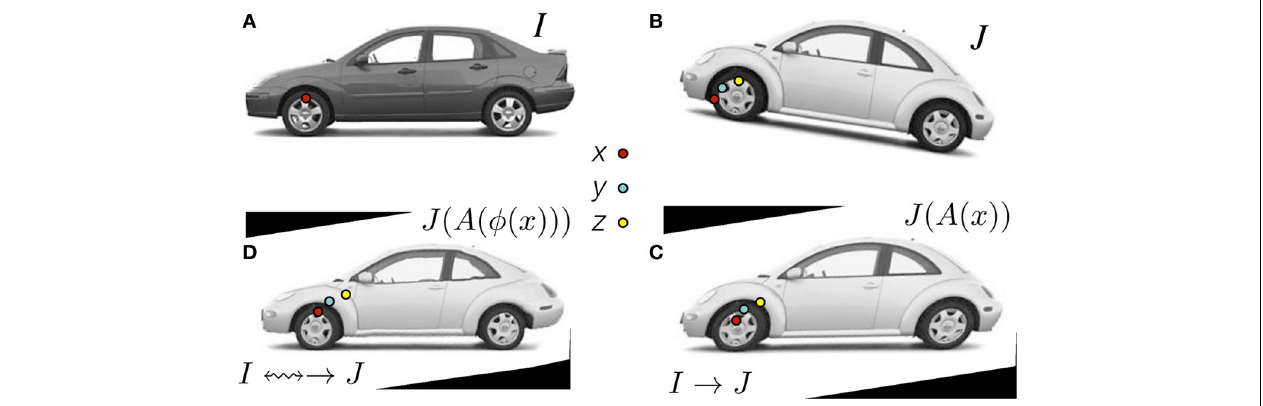
FIGURE 2 | Clockwise: Define x in (cid:2) I and z in (cid:2) J as the same material point but existing in different domains. The point y is in a domain that is intermediate between (cid:2) I and (cid:2) J . The standard approach in the ITKv4 registration framework is to map image J (B) to image I (A) by first identifying the linear transformation, → , between the images, shown in (C) .